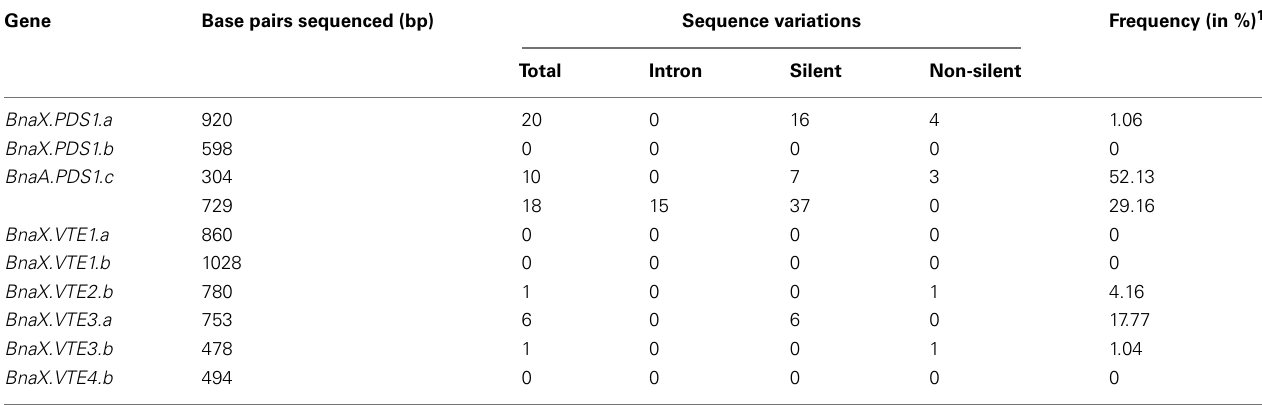
TableA5 | Number of polymorphisms within the amplified gene regions of tocopherol candidate genes from B. napus , their properties and their frequency in panel 1